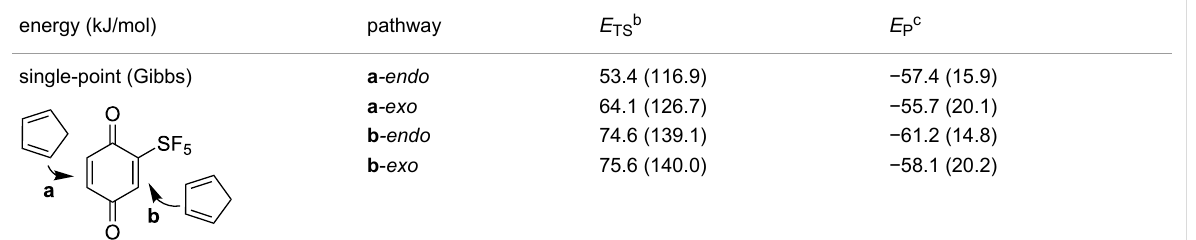
Table 1: Calculated reaction coordinates of Diels–Alder reaction of 12 with cyclopentadiene. a energy (kJ/mol)